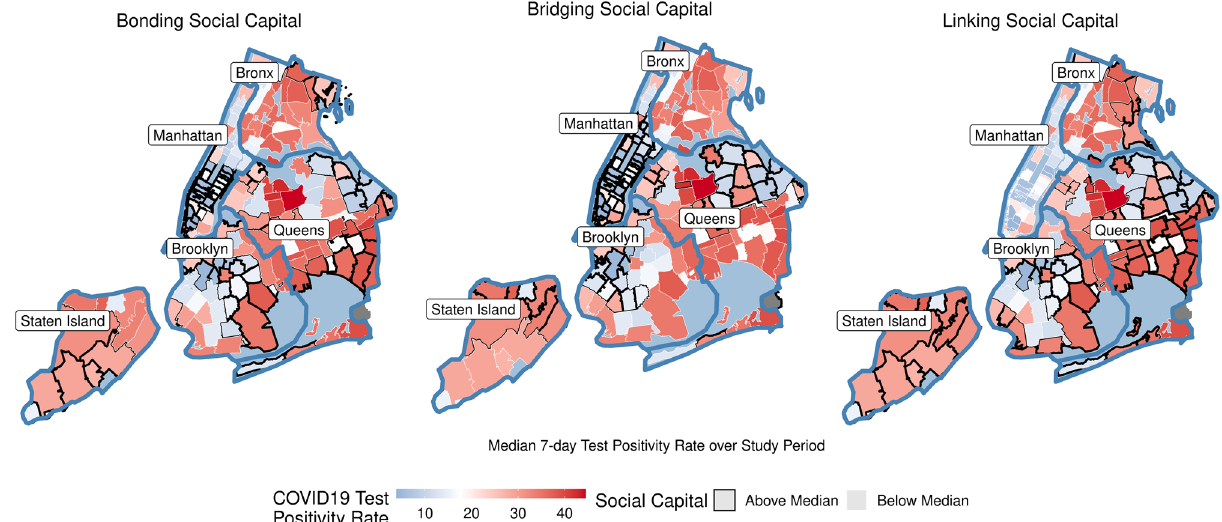
Figure 5. COVID-19 test positivity rates in New York City. Zipcodes of 5 boroughs based on whether above or below the median level of social capital in the NYC area. Blue lines depicting counties, a color scale depicting distance from the median COVID-19 test positivity rate (shaded white), averaged over time. Maps made in R (version 4.0.3) using the sf package (version 1.0-6) 81